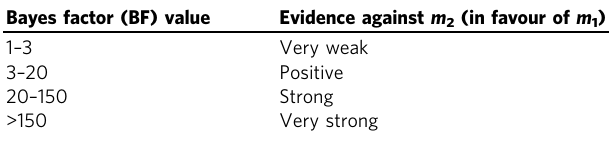
Table 2 Bayes factor categorisation to describe evidence in favour of m 1 , compared with m 2